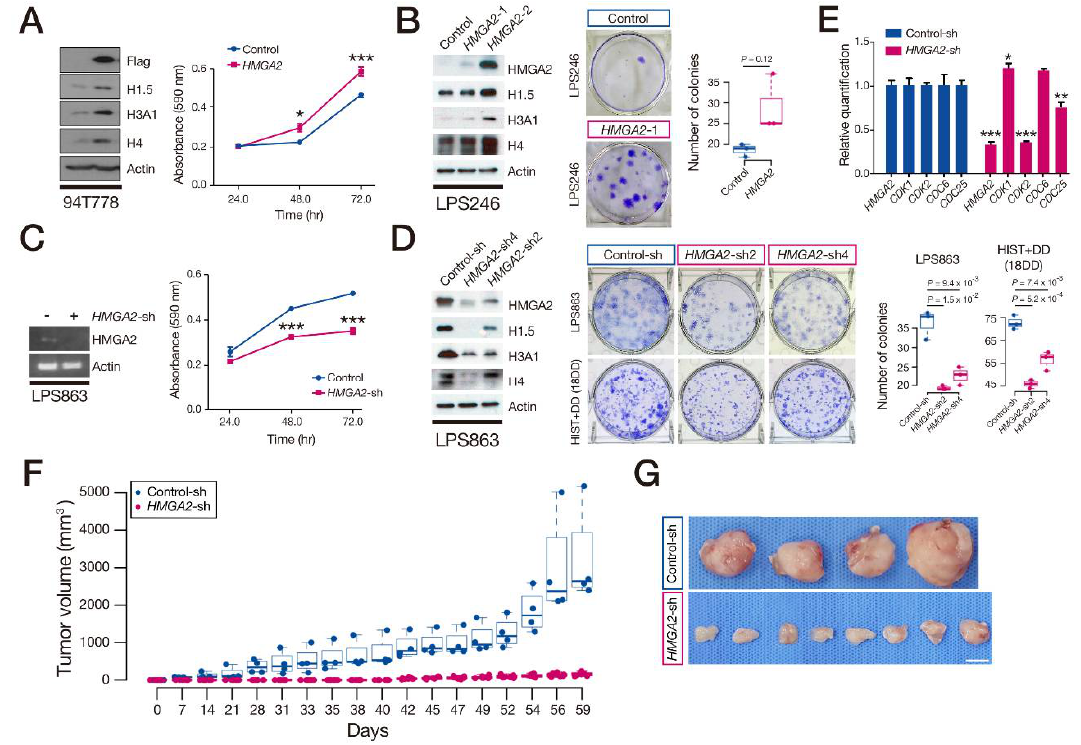
Figure 4. HMGA2 controls RD-HIST expression, LPS cell proliferation, and tumor size. ( A ) Exogenous introduction of HMGA2 in 94T778 cells and difference in cell proliferation measured using MTT assays. ( B ) Western blot of selected histones on LPS246—a DDLPS cell line (left) and colony formation assay (right). ( C ) Knockdown of HMGA2 in LPS863 cells and difference in cell proliferation using MTT assays. ( D ) Western blot of selected histones on LPS863—a DDLPS cell line (left) and colony formation assay (right)—using knockdown of HMGA2 on LPS863 and 18DD cells. ( E ) RT-PCR quantification of cell-cycle genes in LPS863 cells expressing control-shRNA or HMGA2 -shRNA. ( F ) Growth of control and HMGA2 -knockdown cell xenografts in mice. ( G ) Whole-mount images of the xenograft samples in ( F ). Scale bar: 1 cm. ( A , C , E ) Data presented as the mean ± SD from three independent experiments (*, p < 0.005, **, p < 0.05, ***, p < 0.001).